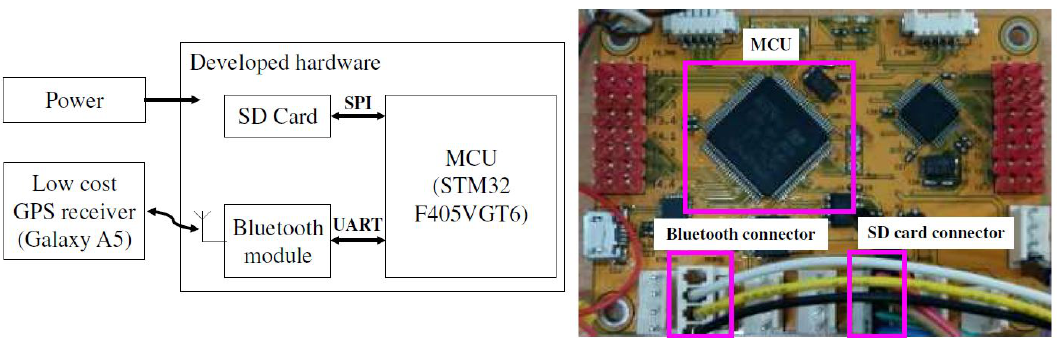
Figure 5. System block diagram and photograph of the developed embedded